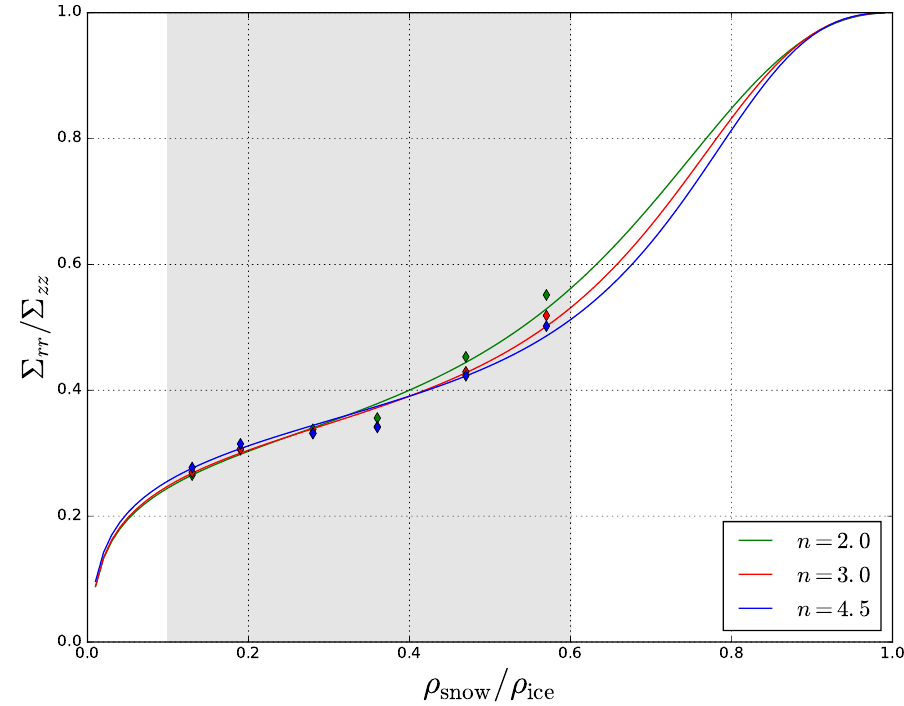
Figure 10. Evolution of the ratio between the lateral and axial stresses with respect to snow relative density during any oedometric compres- sion test for different values of the exponent n (numerical points as diamond points; functions corresponding to Eq. 29 as solid lines). The relative density range for typical snow samples is materialized by the gray